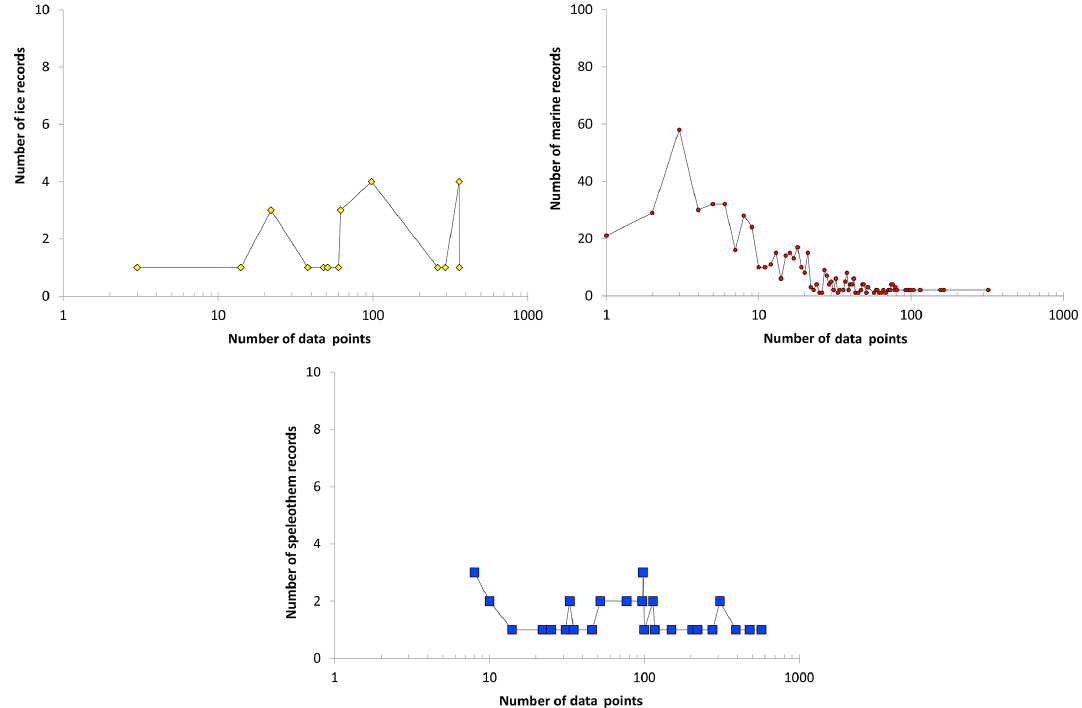
Figure A4. Same as Fig. 1 but for the last interglacial (115–130ka). Note the different vertical